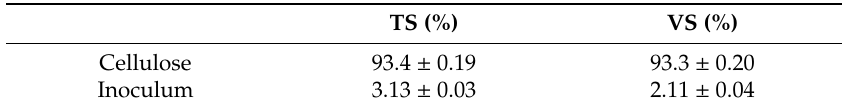
Table 1. TS and VS values of cellulose and inoculum expressed in percentage of total mass (mean and standard deviation, n =